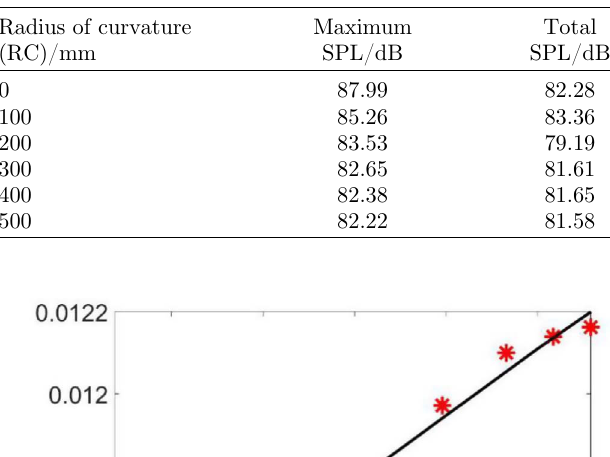
Figure 14. Acoustic scattering effects of cuboid fuselages with different RC. Table 4. Maximum and total SPLs of helicopters with cuboid fuselages of different RC.